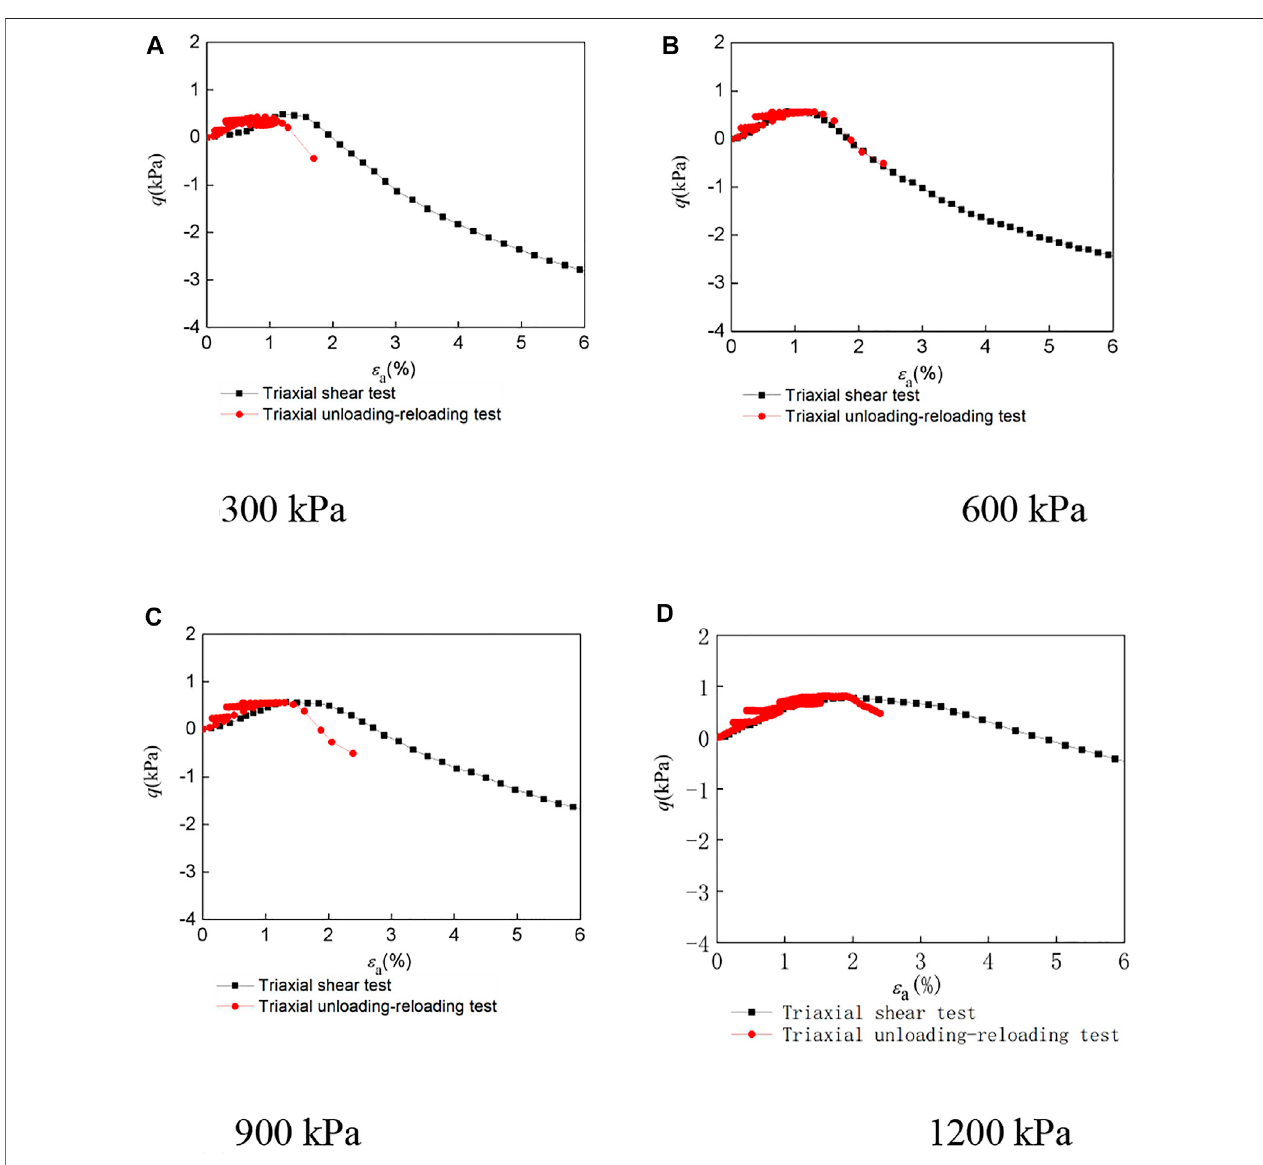
FIGURE6| Volumetricstrain – axialstraincurvesofLCSGmaterialwithcementedcontentof60 kg/m 3 underdifferentcon fi ningpressures. (A) 300 kPa (B) 600 kPa (C) 900 kPa (D) 1,200 kPa.